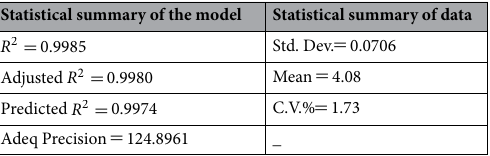
Statistical summary of the model Statistical summary of data R 2 =